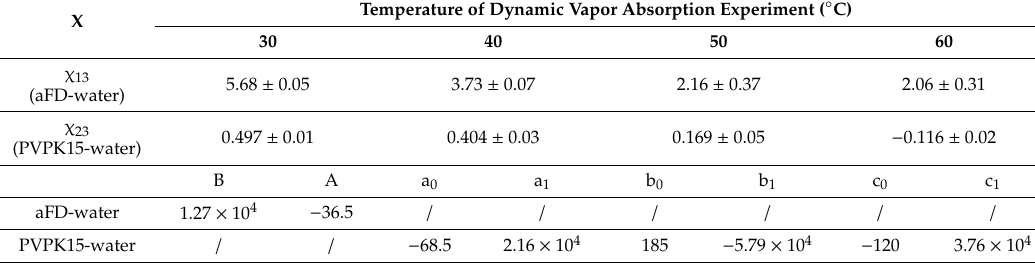
Figure 4. ( a ) Calculated F–H interaction parameter χ 13 for aFD-water system at 30 ◦ C, 40 ◦ C, 50 ◦ C and 60 ◦ C; ( b ) The interaction parameter of χ 13 (aFD-water) as a function of temperature by fitting Equation (B3) (Supplementary Materials B) ( χ = A + B / T); ( c ) Calculated F–H interaction parameter χ 23 for PVPK15-water at 30 ◦ C, 40 ◦ C, 50 ◦ C and 60 ◦ C ( d ) The interaction parameter of χ 23 as functions of temperature and drug loading (u 2 ) by fitting Equation (B4) (Supplementary Materials B). Table 1. The calculated F–H interaction parameters and their fitted coefficients of Equations (B3) and (B4) (Supplementary Materials B) for aFD-water and PVPK15-water system at 30 ◦ C, 40 ◦ C, 50 ◦ C, and 60 ◦ C, data were presented with average ± standard deviations for F–H interaction parameters ( n =